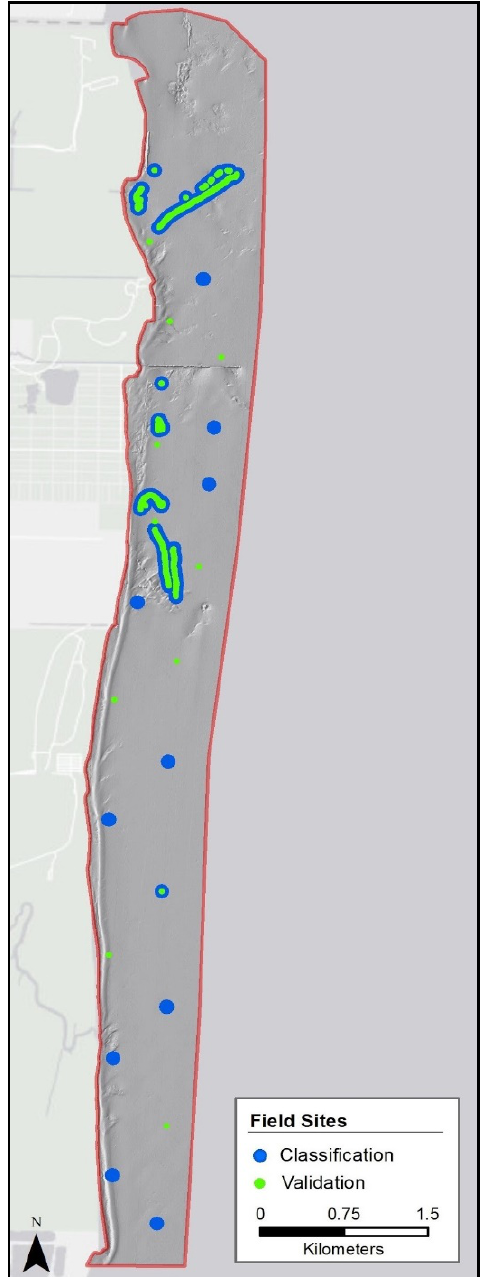
Figure 4. Field data collected in July 2018 and summer and fall 2019 used for image classification and validation.